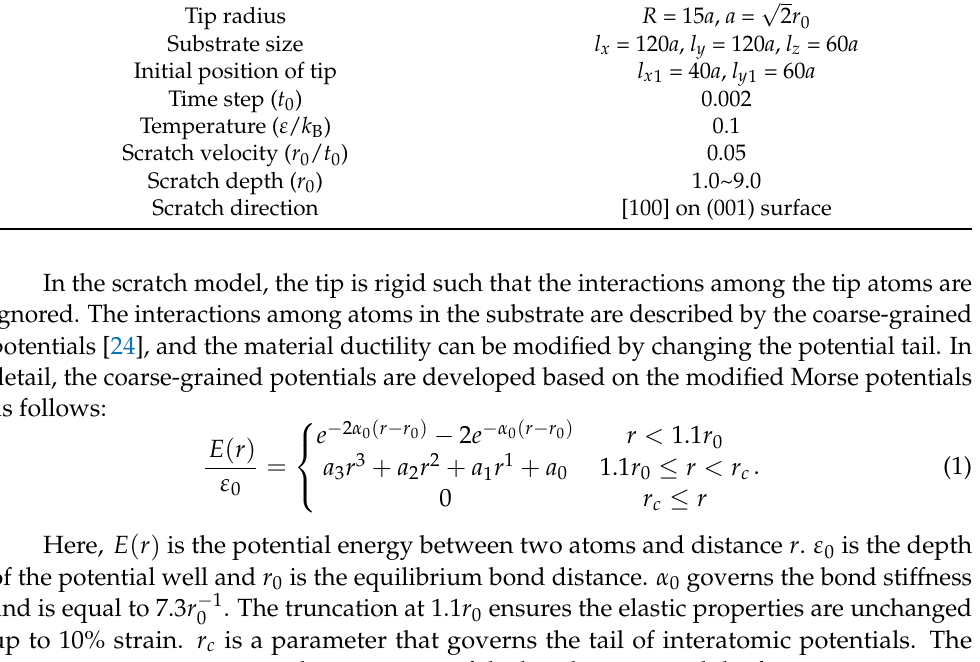
Figure 1. ( a ) Geometry of the nanoscratch model. ( b ) Two-step loading of the scratch process. Table 1. Parameters for the scratch test with coarse-grained potentials.